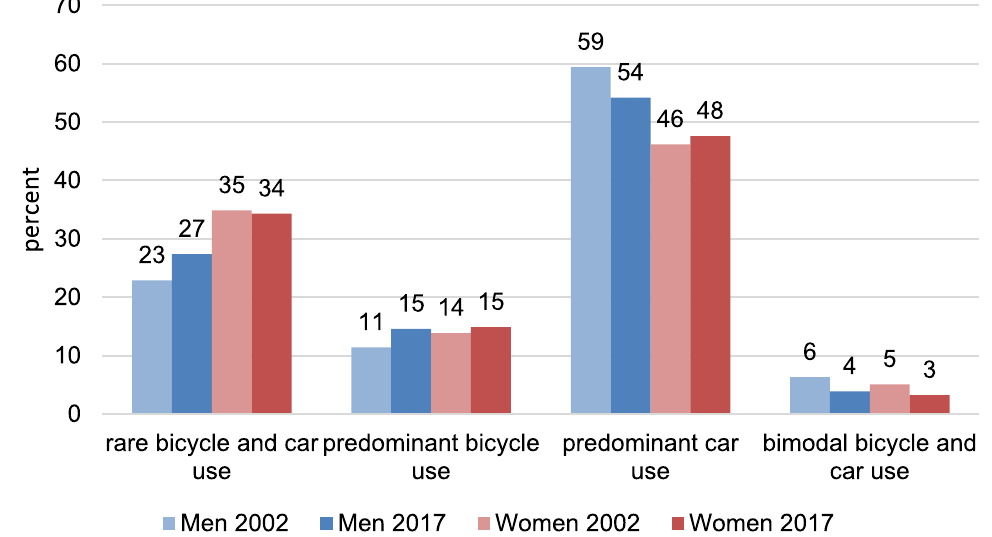
Fig. 1 Mobility type by gender and year of survey. Source: Mobility in Germany: MiD person-time-series dataset (own calculations). Survey weights are applied